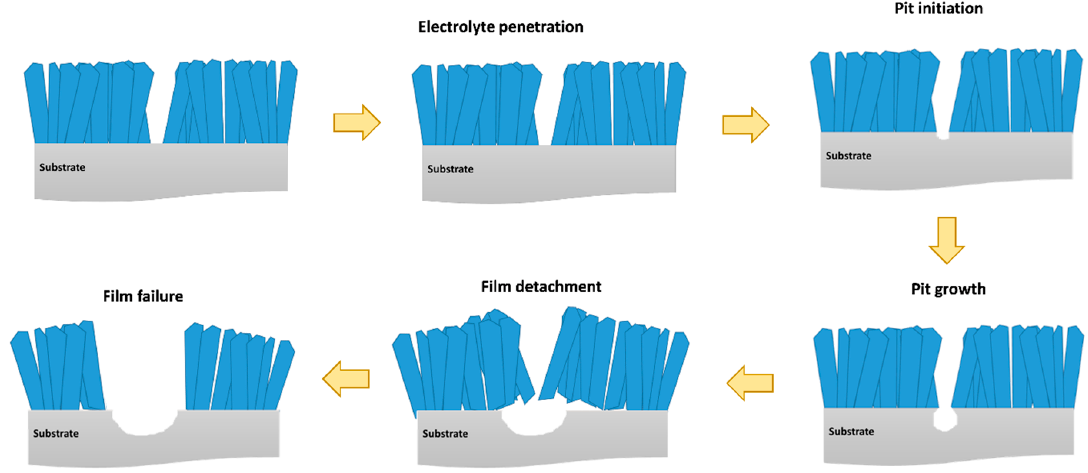
Figure 11. Coatings’ delamination promoted by corrosion processes.